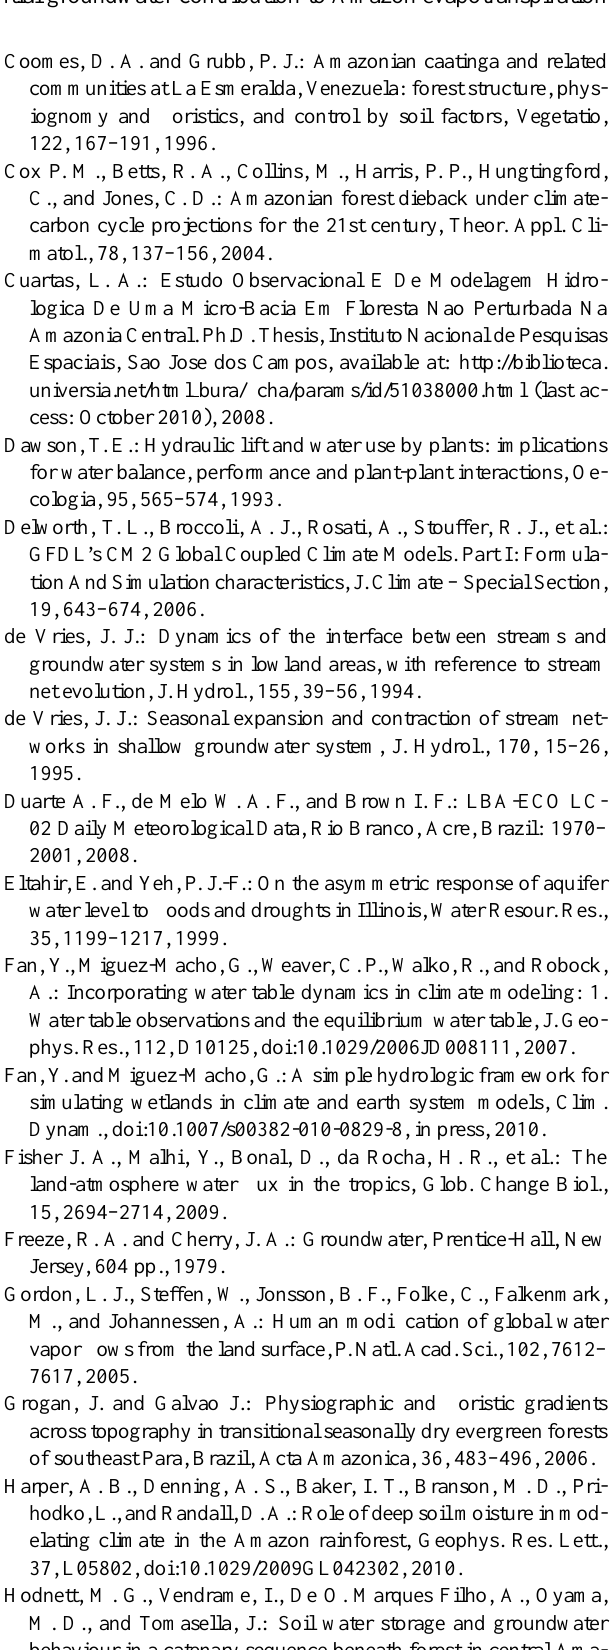
A.: Incorporating water table dynamics in climate modeling: 1. Water table observations and the equilibrium water table, J.